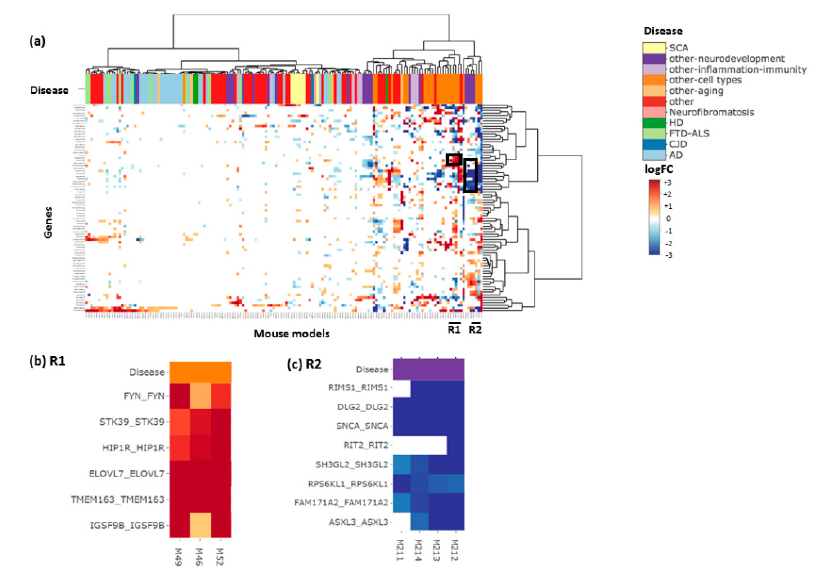
Figure 5. Examining nearest genes to top variants associated with PD. ( a ) The heatmap for nearest genes to single-nucleotide polymorphisms (SNPs) significantly associated with PD from a large PD genome-wide association study (GWAS) [13] . ( b ) A zoom-in into the R1 boxed region consisting of three DEGs (M49, M46, M52) studying cell types in the mouse. ( c ) A zoom-in into the R2 boxed region consisting of four DEGs (M211, M214, M213, M212) related to microglia development.